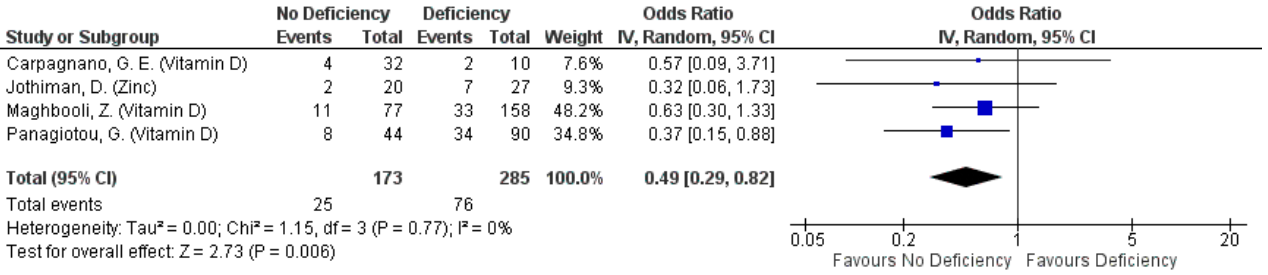
Figure 3. Pooled odds ratio on mortality from COVID-19 episode, or during hospitalisation due to COVID-19 episode when hospitalized subjects are not deficient, compared to those deficient in any micronutrient singly.